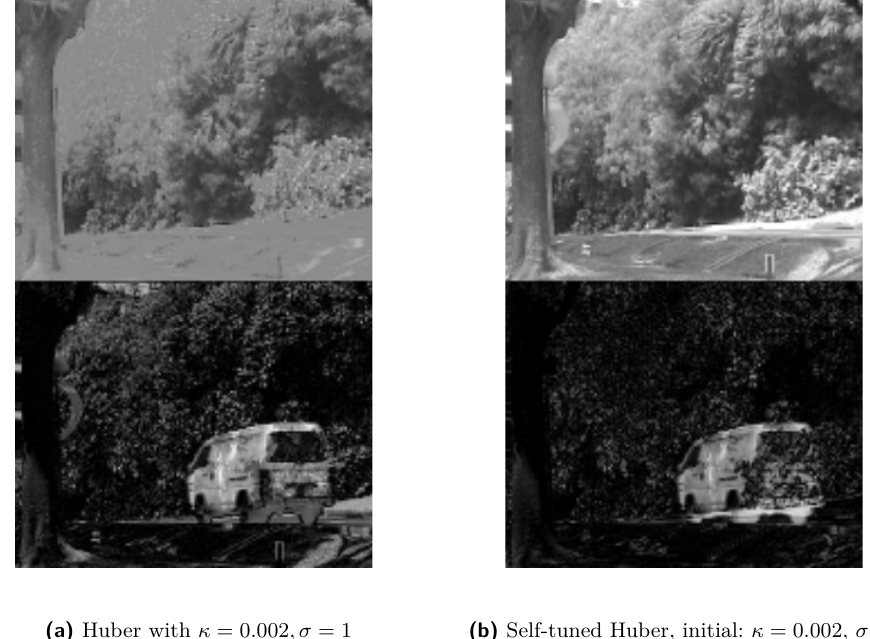
Figure 10 RPCA background separation: we optimize over parameters as well as the foreground and background. The separation is better as a result of the joint